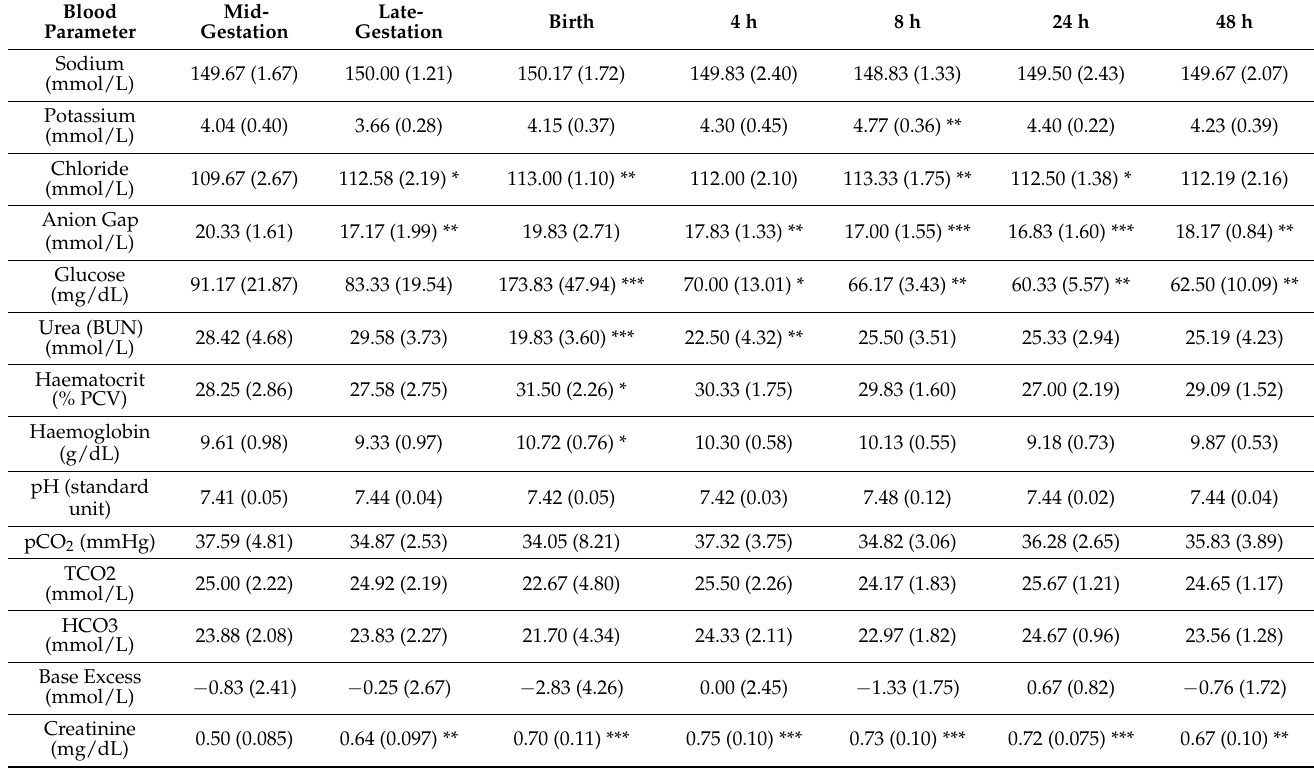
Table 2. Average (s.d.) values for investigated blood parameters measured at mid-gestation, late gestation, birth and 4 h, 8 h, 24 h, and 48 h post-birth. Comparisons are between mid-gestation and subsequent time